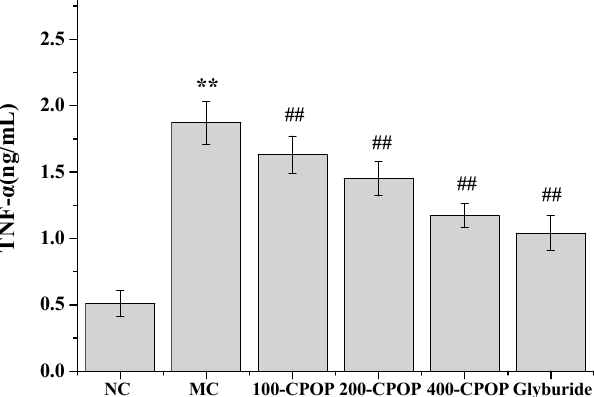
Figure 6. Effect of CPOP on tumor necrosis factor- α (TNF- α ) levels in STZ-induced diabetic rats. ** p < 0.01 vs. NC group ( N = 8); ## p < 0.01 vs. MC group ( N = 8). NC is the normal control group; MC is the model control group; 100-CPOP is the 100 mg/kg per body weight CPOP group; 200-CPOP is the 200 mg/kg per body weight CPOP group; 400-CPOP is the 400 mg/kg per body weight CPOP